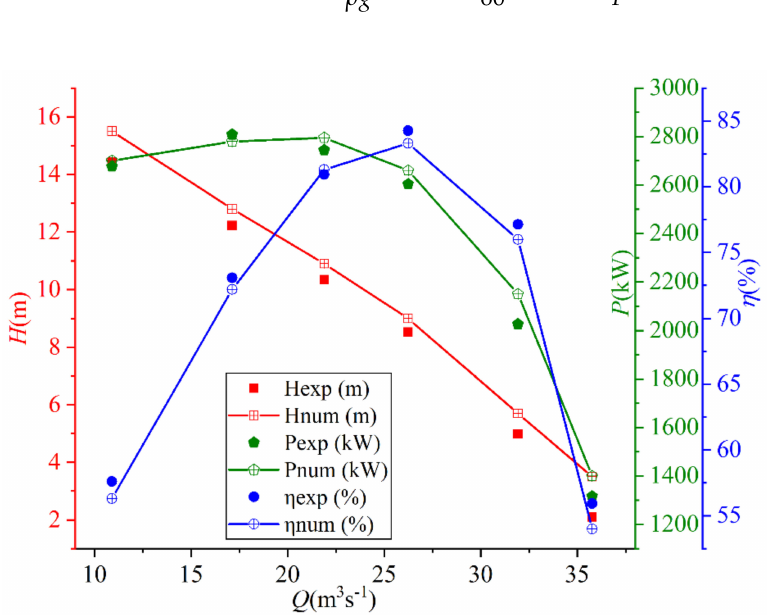
Figure 7. Comparison between numerical and experimental